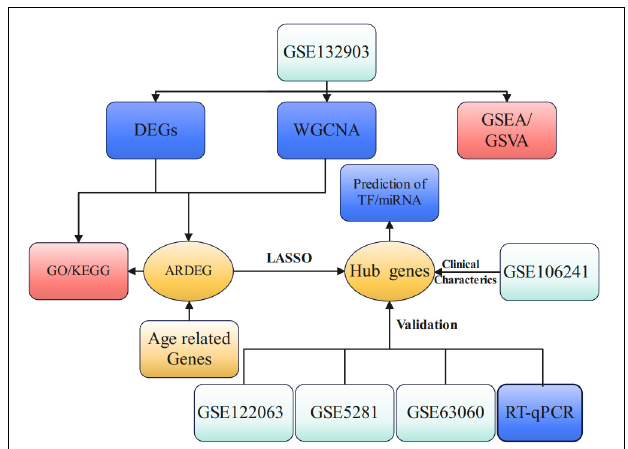
FIGURE 1 | Study flow chart of present work. DEGs, differential expression genes; WGCNA, weighted gene co-expression network analysis; GSEA, gene set enrichment analysis; GSVA, gene set variation analysis; ARDEG, age-related differential expression genes; GO, gene ontology; KEGG, kyoto encyclopedia of genes and genomes; LASSO, least absolute shrinkage and selection operator; TF, transcriptional